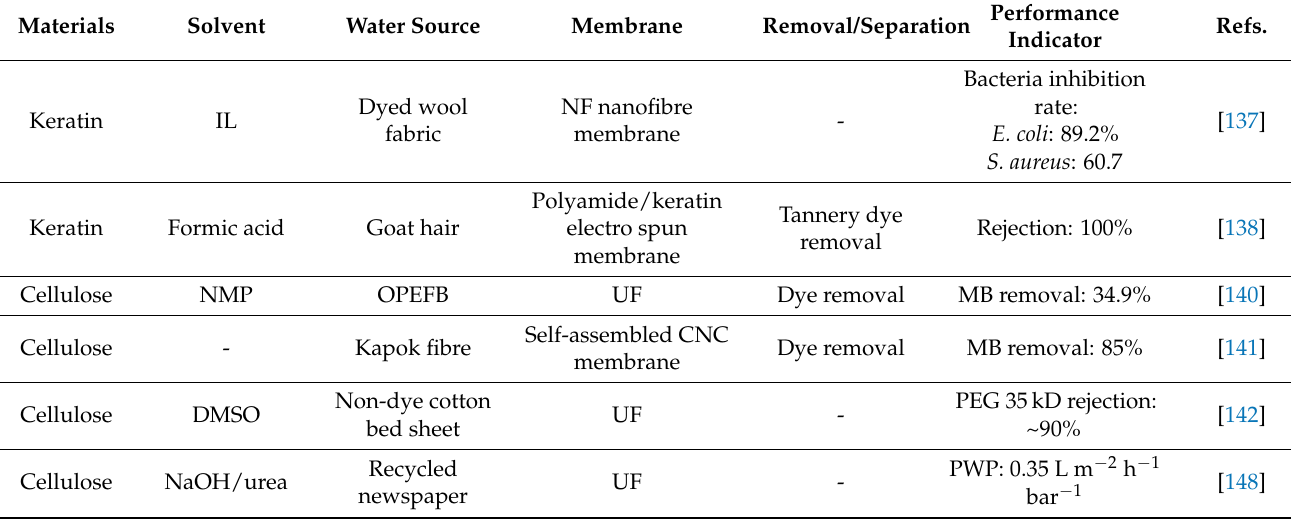
Table 1. Summary of polymeric membranes prepared from waste sources of keratin, cellulose, polymer, and plastic.